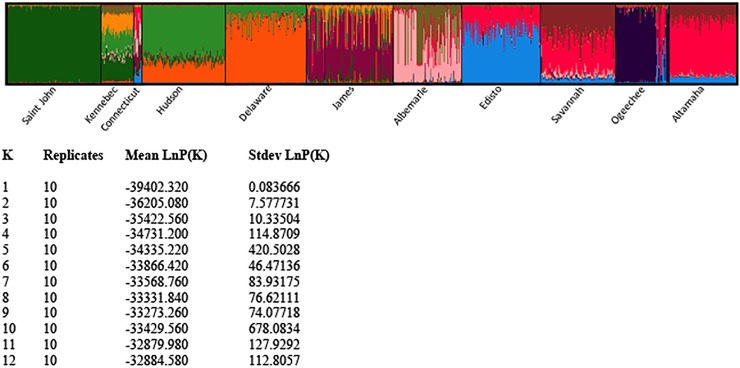
Bar plot and table of Ln Pr (X/K) value of results of STRUCTURE analysis (K = 11).The optimal delta K value was also 11. Results are based on microsatellite DNA analysis at 11 loci in 11 collections of Atlantic sturgeon. All collections were of juveniles (< 50 cm TL) or adults (> 130 cm TL) specimens except for that from the Connecticut River which included 5 juveniles between 50 and 56 cm TL.